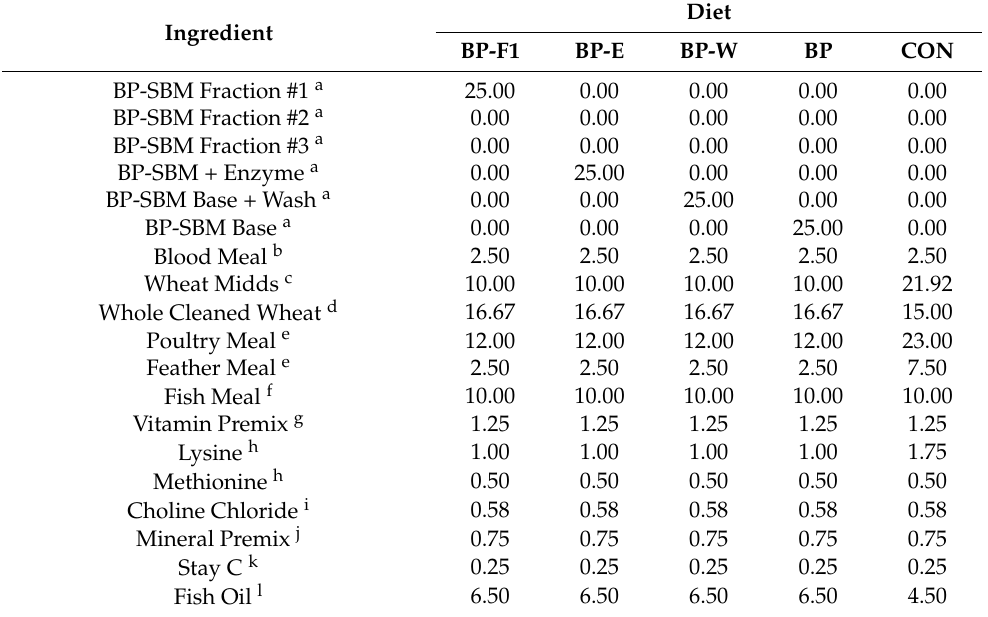
Table 1. Experimental diet formulations used in the 105-day growth trial. All values are shown as g/(100 g dry